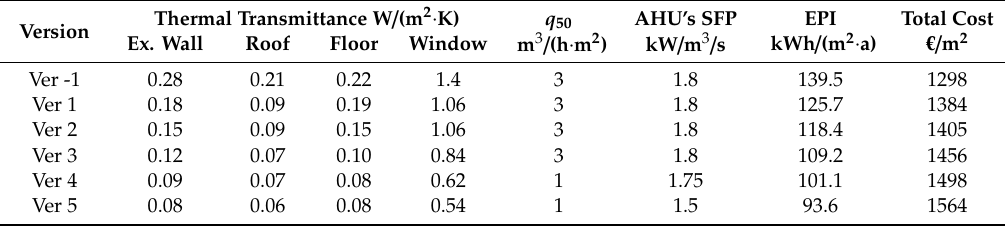
Table 8. Combinations of di ff erent insulation solutions.